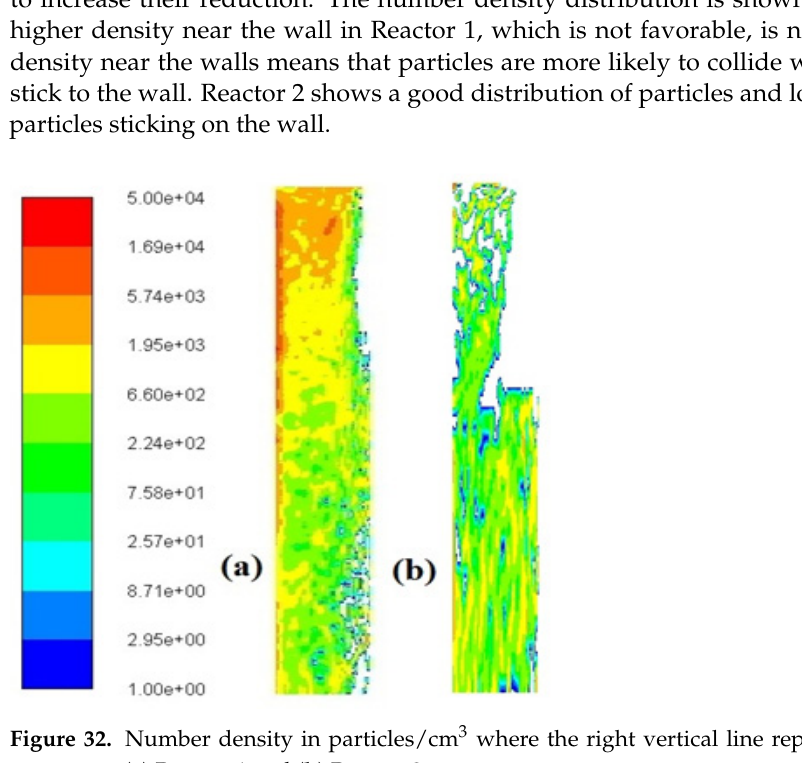
Figure 32. Number density in particles/cm 3 where the right vertical line represents the axis of symmetry: ( a ) Reactor 1 and ( b ) Reactor 2.